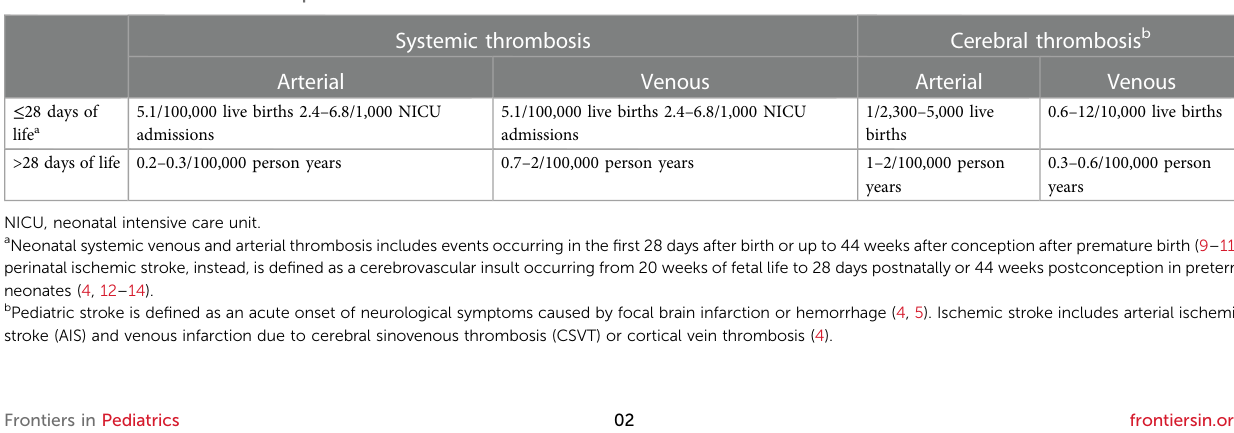
TABLE 1 Incidence of neonatal and pediatric thrombotic